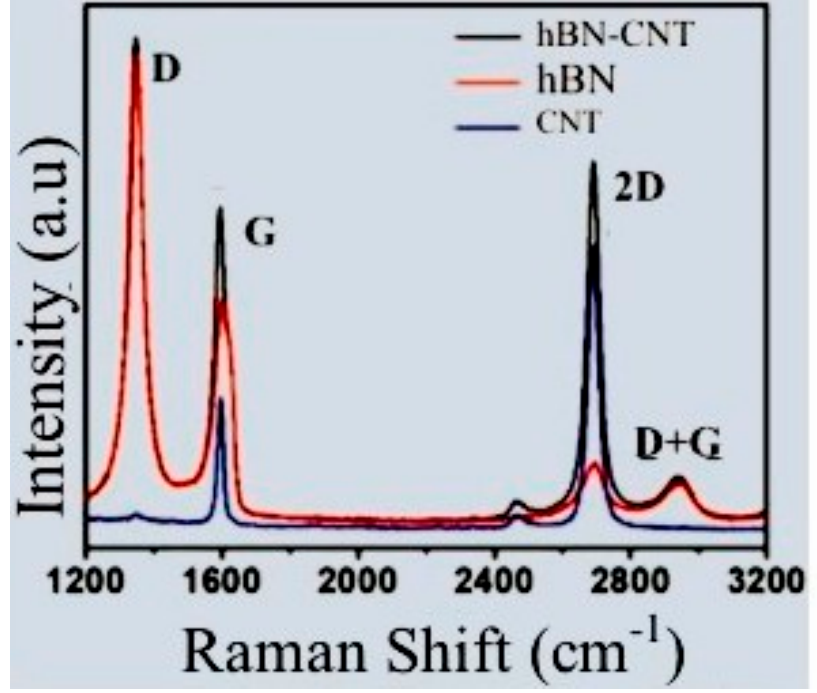
Figure 7. The doping effect in the h -BN-CNT interlayer. Figure 7 shows the regions of the h -BN-CNT defined by Raman spectra via the D, G, 2D, and D+G bands as the fingerprint of the synthesized hetero-structure. The Raman spectrum is similar to that of a CNT (as a high-intensity D band peak of 1345 cm − 1 ) because both of their spectra are characterized by the dependence of the position of the Raman-active wave number ranges as a function of the encapsulated tube diameter [20]. This transformation can be attributed to the similar thermodynamic profiles of the two nanomaterials. h -BN transforms to boron nitride nanotube (BNNT) at a high temperature just like graphene turns to CNTs at high temperatures [21,22]. The characterization of the 2D/G ratio (approx. 3) revealed the crystalline nature of the CNT. There is also a broad G peak and also D+G peaks at 1593 cm − 1 and 2940 cm − 1 respectively. The TGA profile of the three samples of the synthesized SWCNT is shown in Figure 8. As shown, there is a little loss of mass at the initial thermogravimetric stage by all